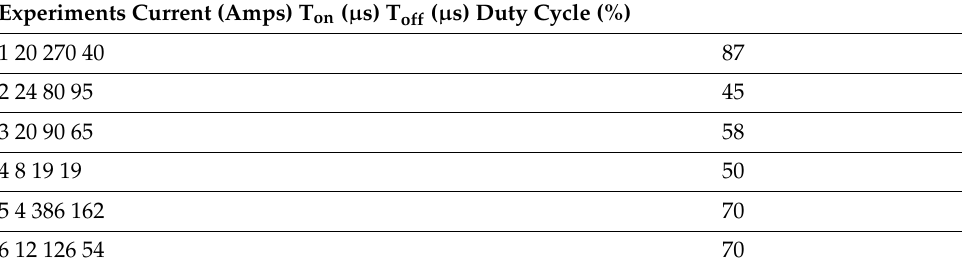
Table 3. Combination of machining process parameters.